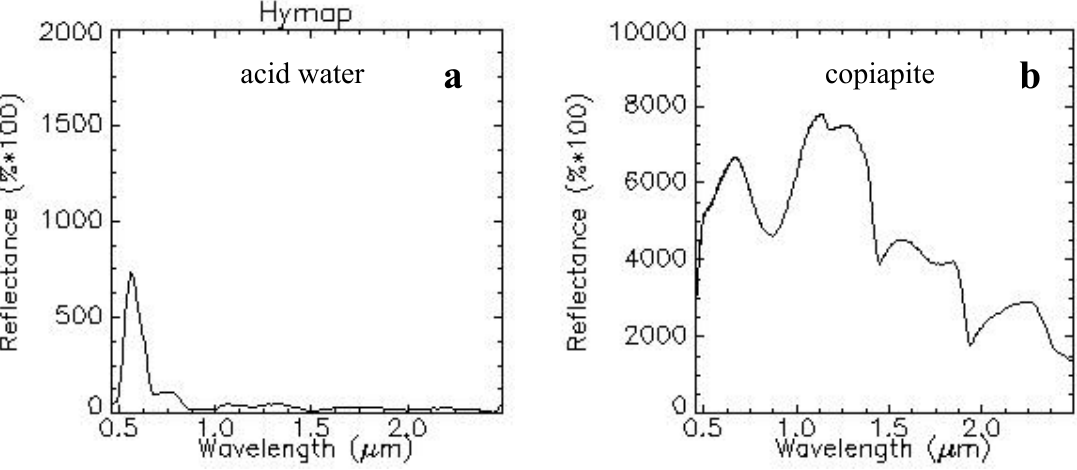
Figure 3. (a) Spectra from acid water extracted from Hymap data (b) Spectra from